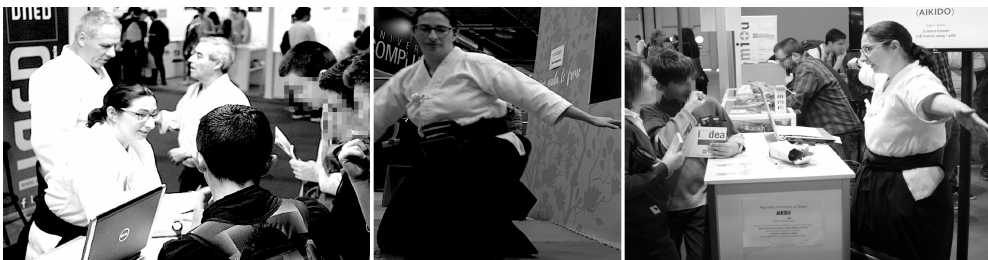
Figure 1. Left: a group of high-school students are asked by the researcher (one of the co-authors of the paper) to participate in the activity. In the background, two members of the Aikime dojo. Center: execution of the suwari waza tai sabaki shikko ho technique with arms opened (increasing moment of inertia/reducing angular speed). Right: debriefing to the participants after filling out the tests. Photos left and right at Feria Madrid 2019 event were taken by divulgaUNED and published on Twitter [12]. The shikko exercise can be roughly compared to walking on knees (also known as samurai-walking